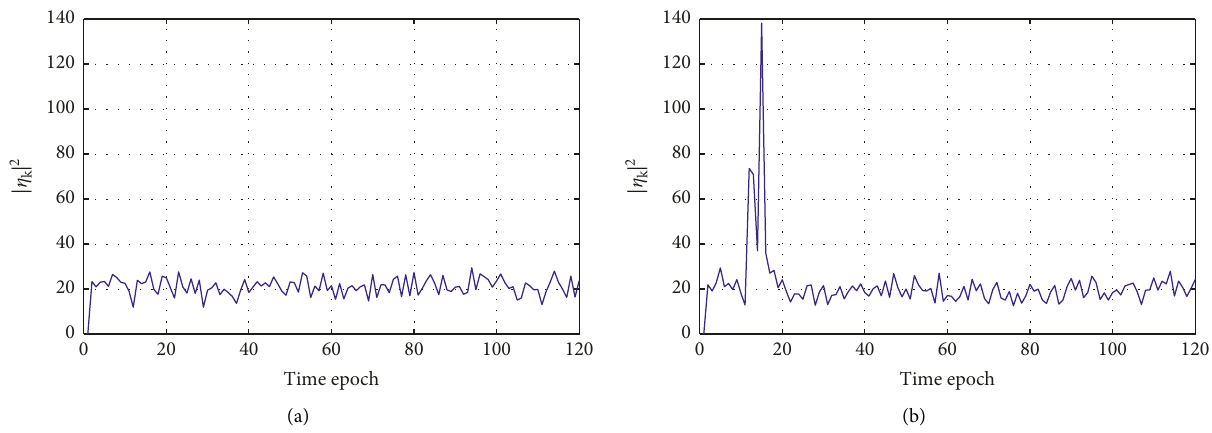
Figure 3: Output plot of the interference monitor. (a) Without the interference. (b) In the presence of interference, JNR � 18 dB. Table 1: Pseudocode and cost of FDPM subspace tracking method. Initial value U ( 0 ) should be orthonormal. Input sequential data vector: r k